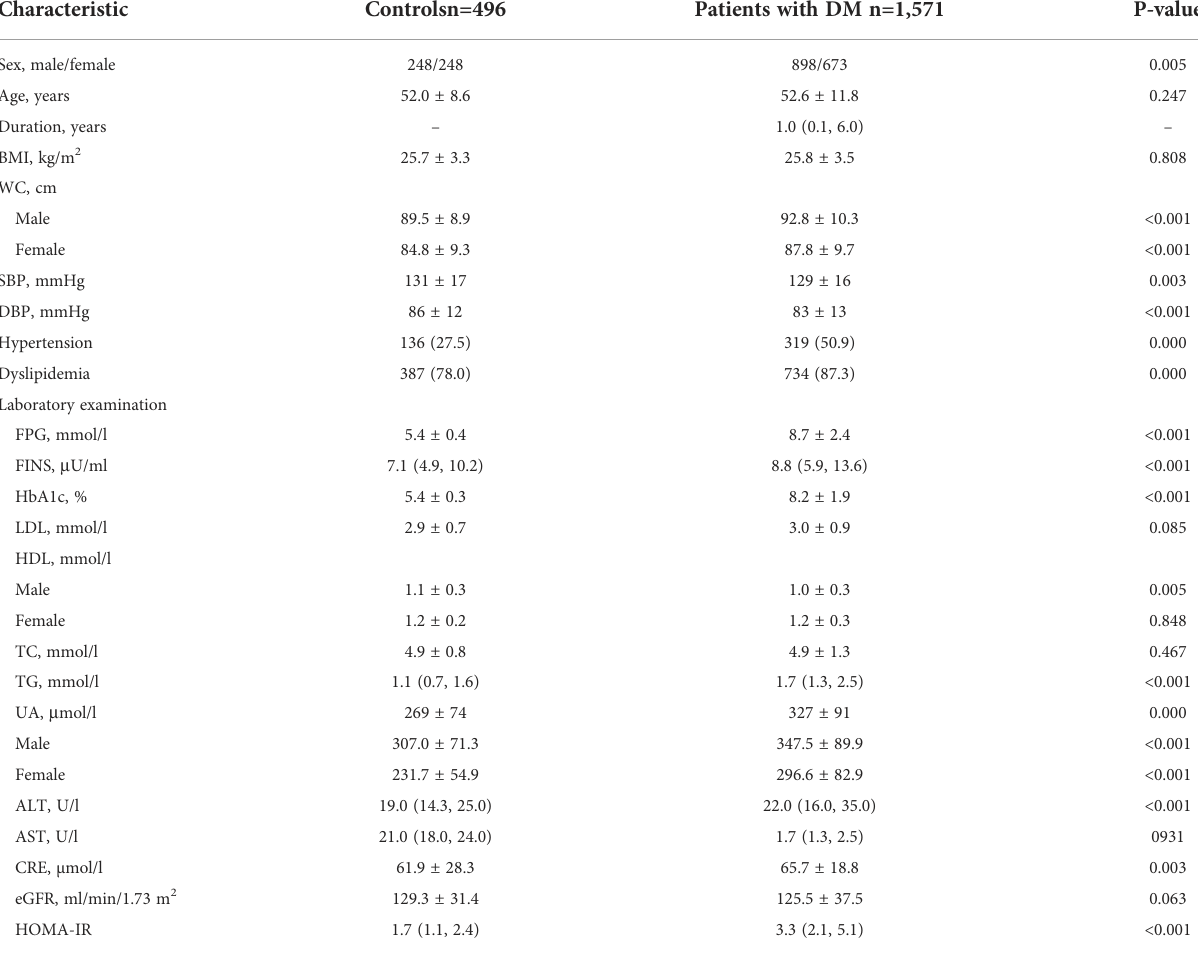
TABLE 2 Characteristics of the subjects of type 2 diabetes or normal glucose tolerance in cohort